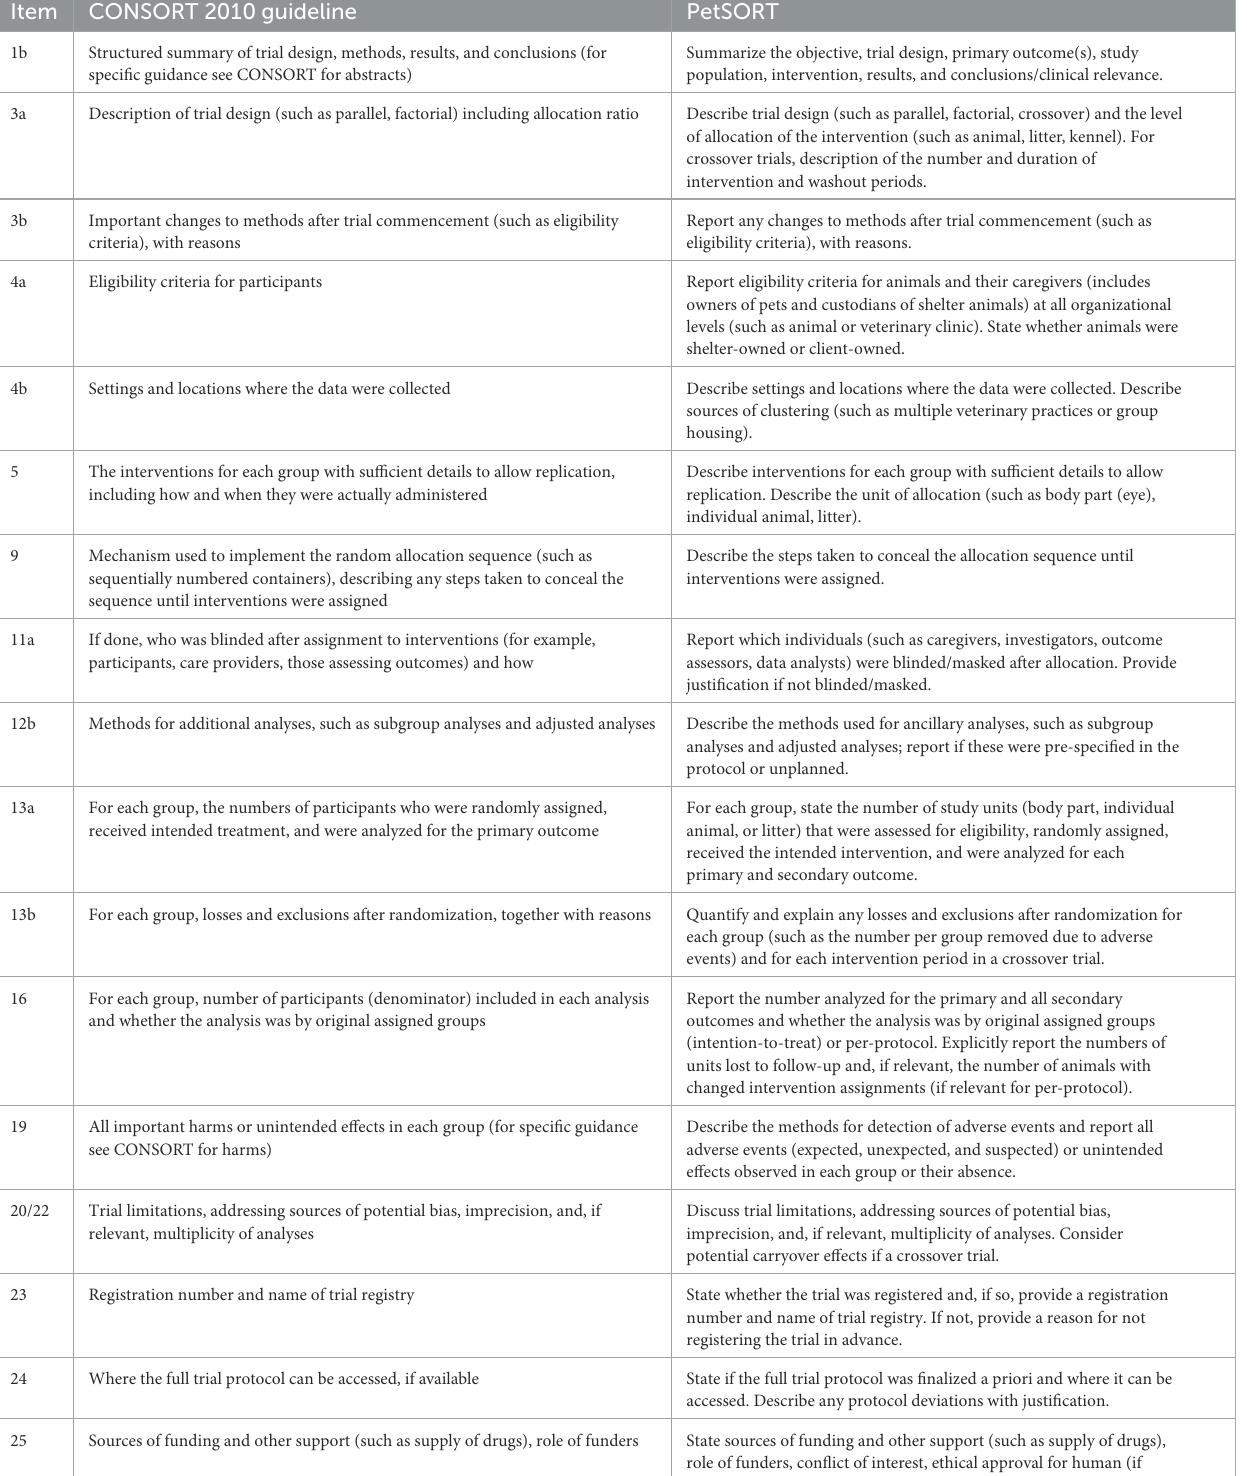
CONSORT 2010 guideline